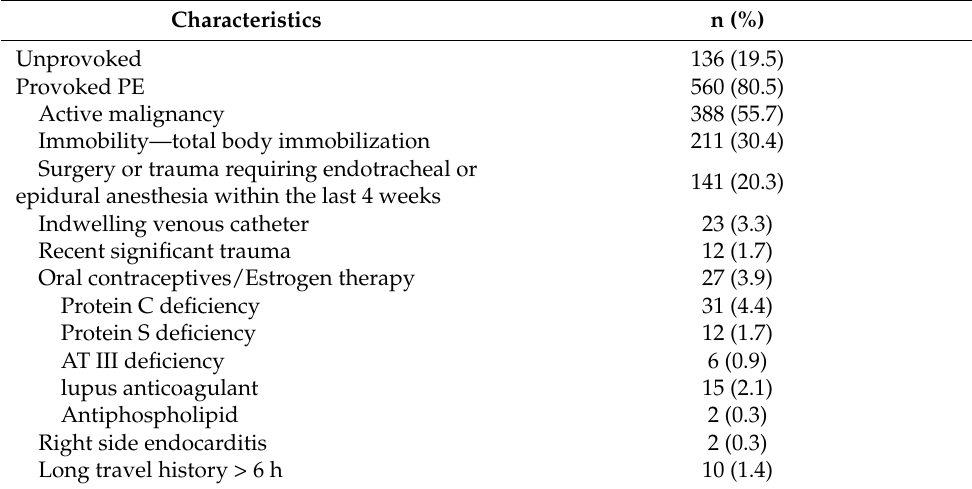
Table 2. Provoked and unprovoked PE.